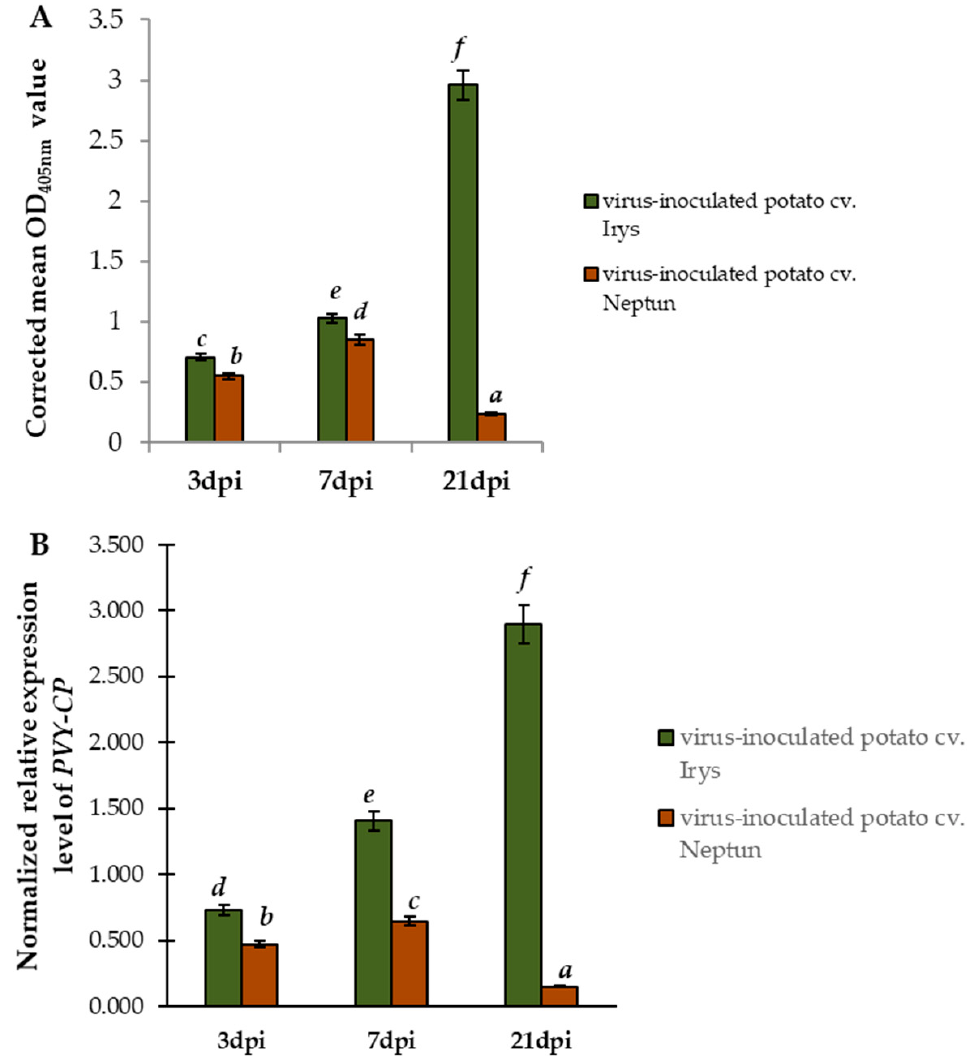
Figure 1. PVY NTN detection and validation of virus concentration in Irys and Neptun plants at 3, 7, and 21 dpi via quantificated DAS-ELISA ( A ) and normalized relative expression of PVY-CP ( B ). ( A ) DAS-ELISA detection of PVY. Values represent mean OD 405nm . ( B ) Normalized relative expression of PVY-CP calculated based on mean expression of StEf1 α and Stsec3 reference genes. The statistical significance of differences was assessed at p < 0.05 using ANOVA with post hoc Tukey’s HSD (marked by letters above the bars).